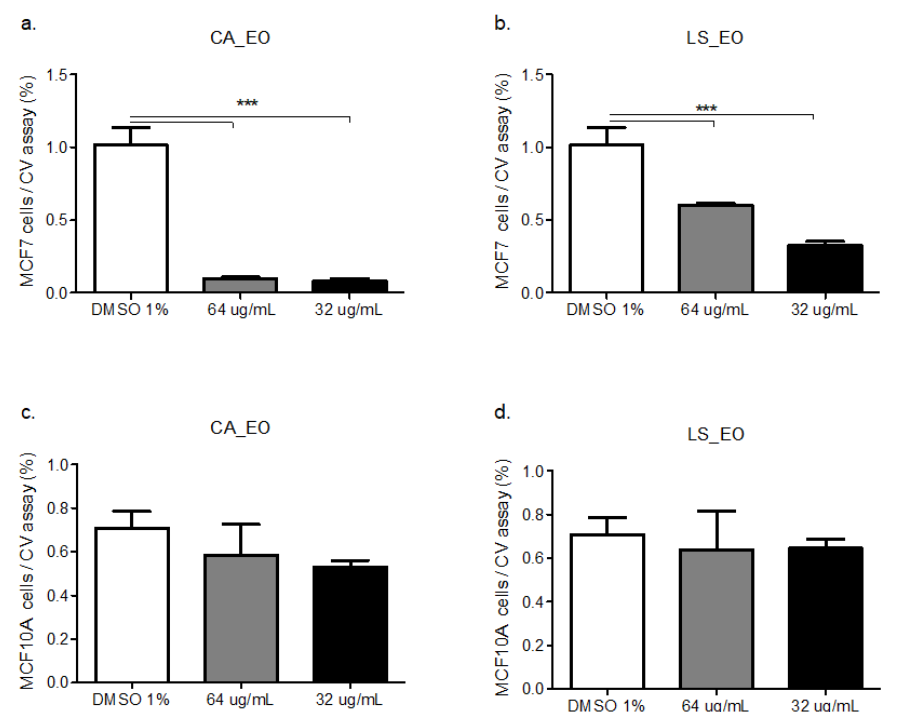
Figure 2. Dose-response curve of the human epithelial mammary tumor cell line MCF-7 ( a , b ) and epithelial mammary non-tumoral cell line MCF10A( c , d ) treated with CA or LS EOs. The graph bar corresponds to the proliferation of MCF-7 treated with the EOs at different concentrations versus control (DMSO 1%) for 48 h, evaluated by CV assay at 570 nm. Three independent trials were performed, in triplicate, for each treatment and concentration. *** p < 0.001.